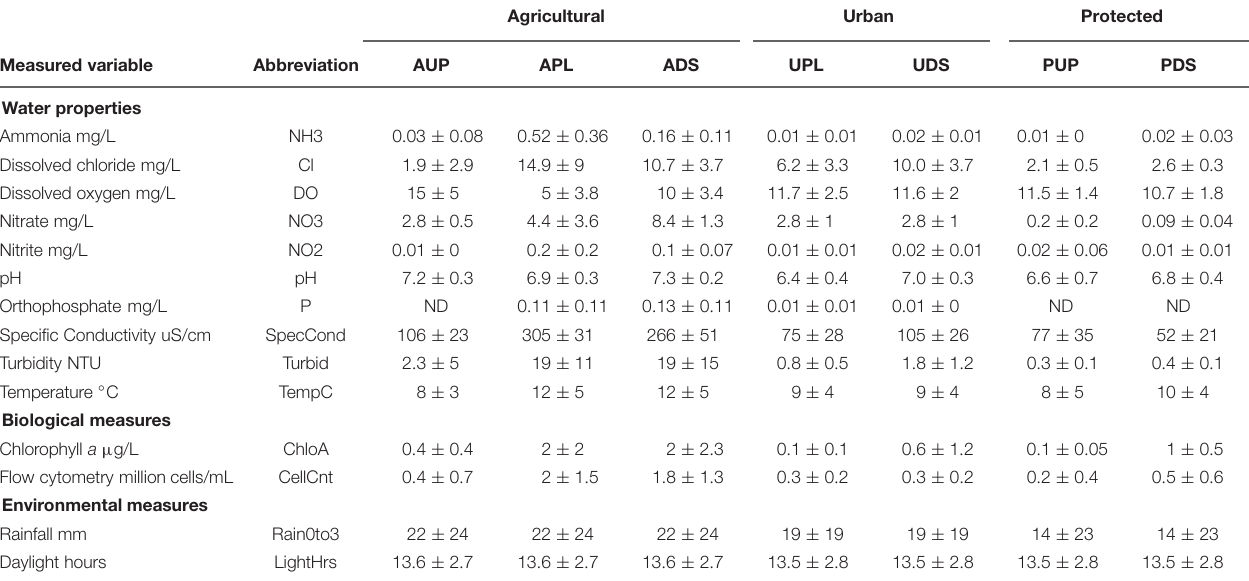
TABLE 2 | Summary of environmental variables over 1 year of sampling: means and standard